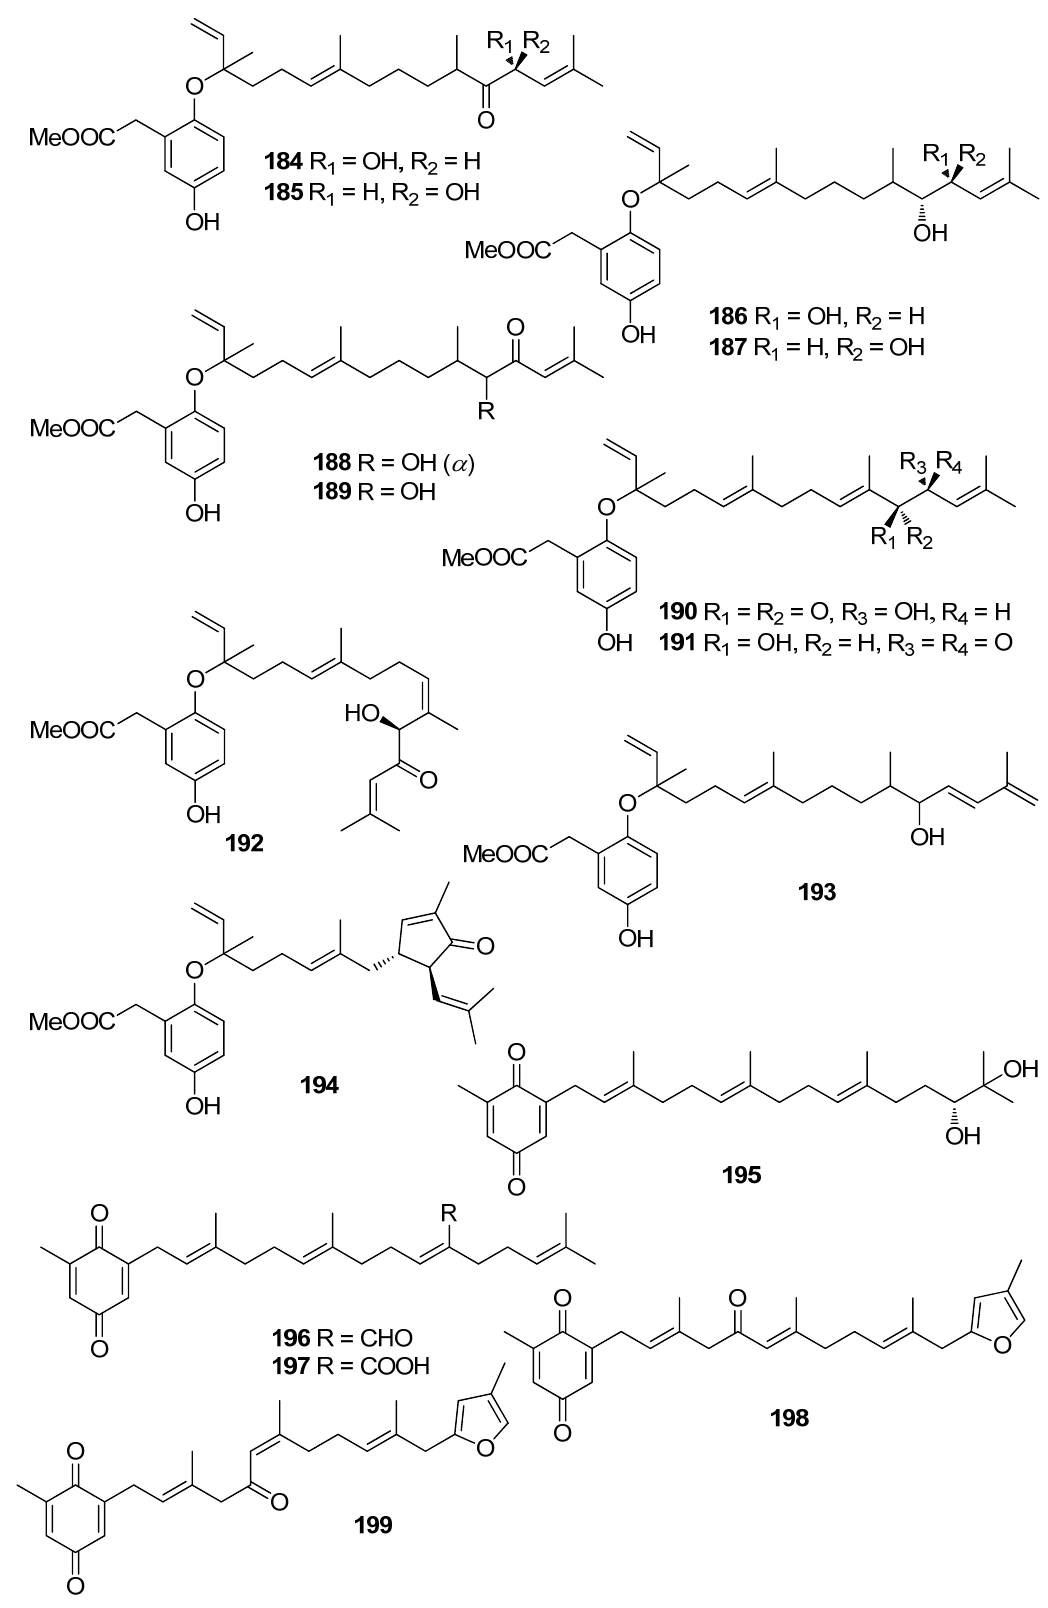
Figure 17. Chemical structures of compounds 184 – 199 .